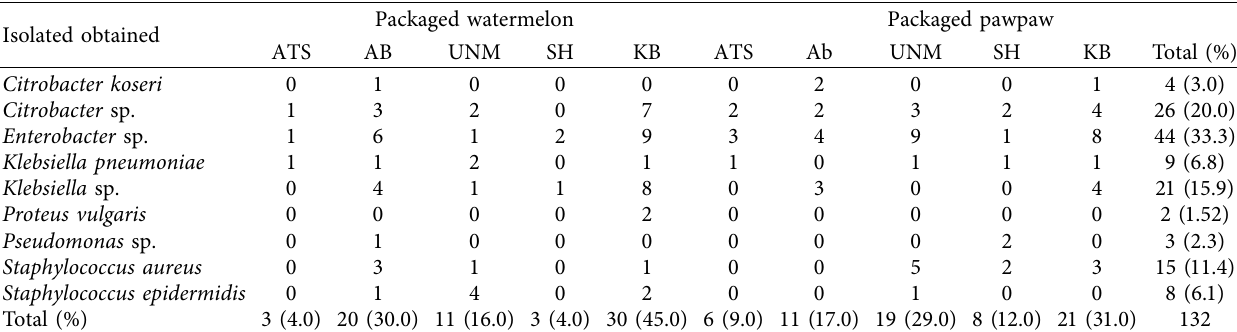
Table 4: Frequency of isolates from packaged watermelon and pawpaw at various locations. Packaged watermelon Packaged Isolated obtained